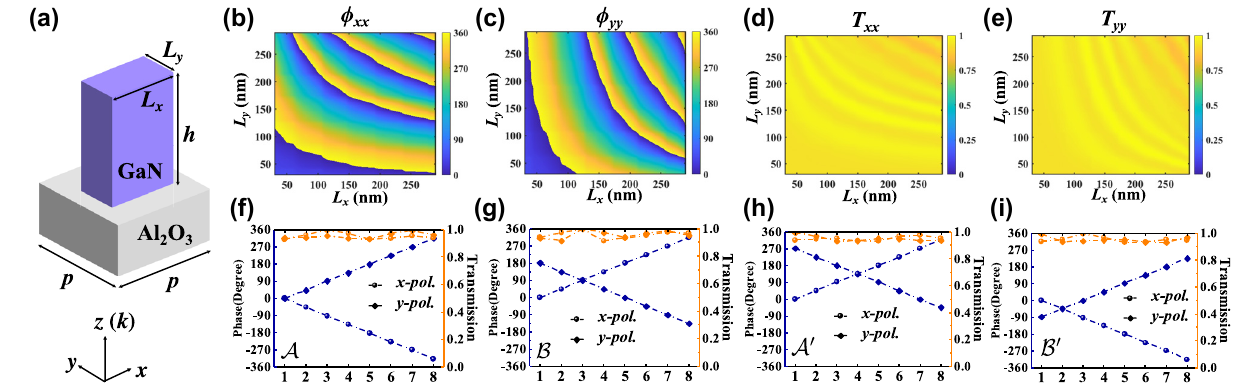
Figure 3: Gallium nitride (GaN) nanopillars with simulated phase and transmission at the wavelength of 700 nm with normal incidence. (a) Schematic illustration of a GaN nanopillar on a sapphire substrate. (c–e) The simulation results for the phase ( 𝜙 ( T and T ) of the transmission coefficients. The width ( L xx yy The selected transmittance and phase of each supercell for the design of pixels with supercells  (f),  (g),  ′ (h), and  ′ (i).